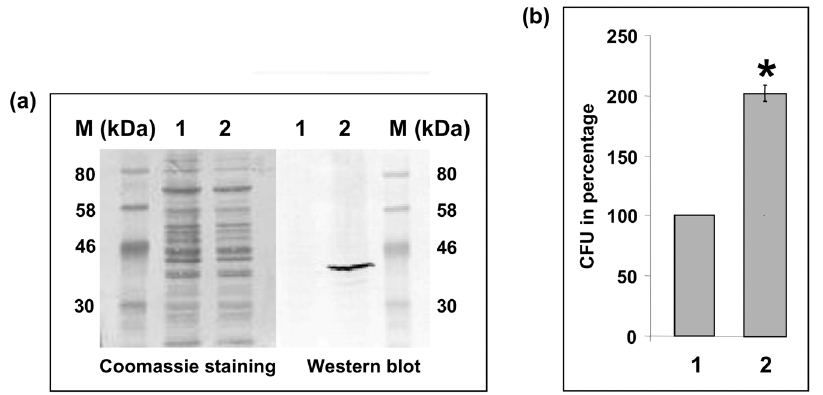
Figure 4. Detection of Cj0268c in E.coli and altered adherence. 1. E. coli DH5 a /pRRC, 2. E. coli DH5 a /pRRC-cj0268cHis. (a) Immunoblot with a monoclonal antibody against the His-tag detected a protein with a molecular weight of 41 kDa corresponding to Cj0268c. The protein was exclusively found in the lysate of the Cj0268c-expressing E. coli . The respective Coomassie staining served as a loading control. (b) Adherence assays on Caco2 cells with Cj0268c-expressing E. coli and E. coli transformed with plasmid pRRC alone. Taken the number of recovered E. coli colonies from the strain harbouring pRRC without cj0268c as 100%, the mean value of the adherence capacity of E. coli DH5 a /pRRC-cj0268cHis was 201.7% ( 6 6.44, P , 0.0039).